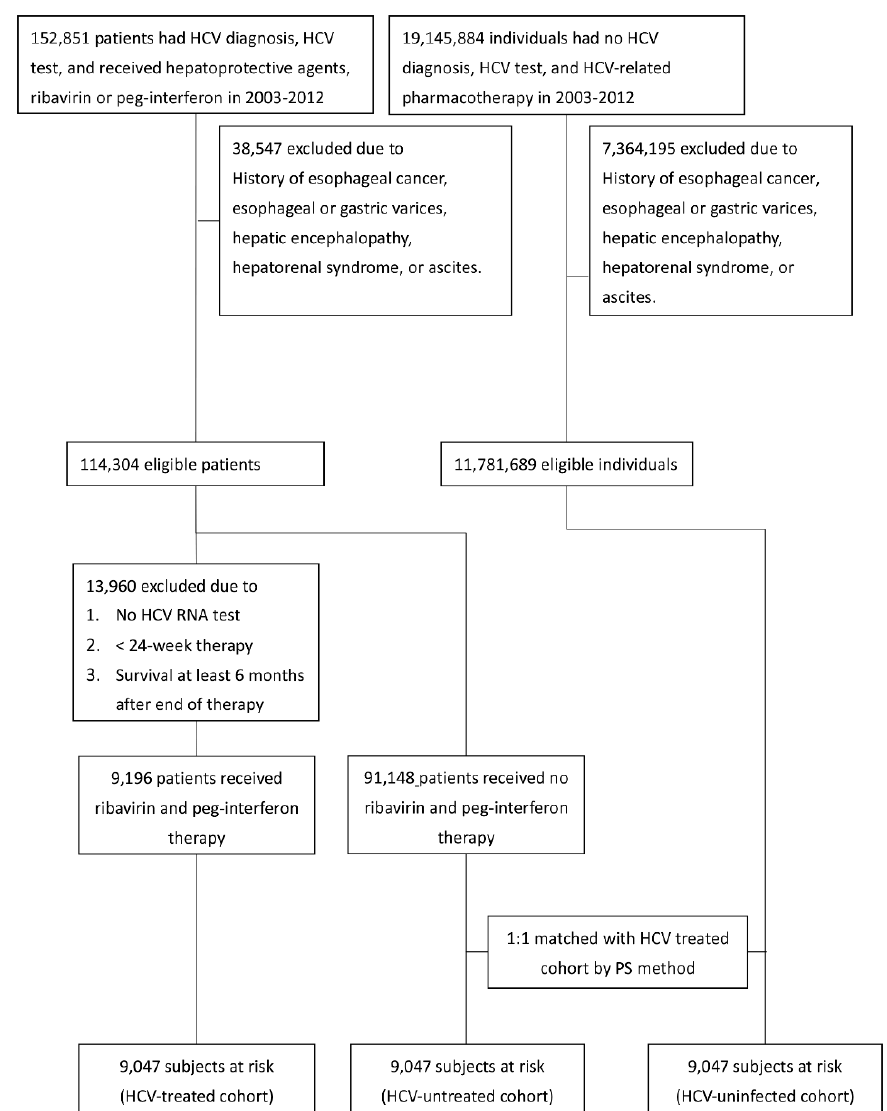
Figure 1. Flow chart of TNHIRD study subjects’ selection. TNHIRD: Taiwan National Health Insurance Research Database; HCV: hepatitis C virus; Peg-IFN: pegylated interferon; PS: propensity score.